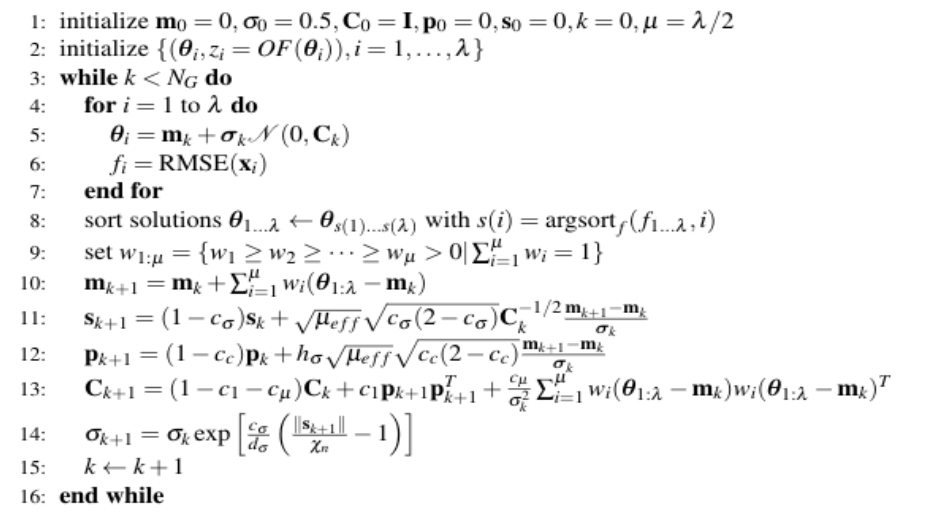
Algorithm 1. Pseudocode of the CMAES searches the internal parameters of the machine learning models.